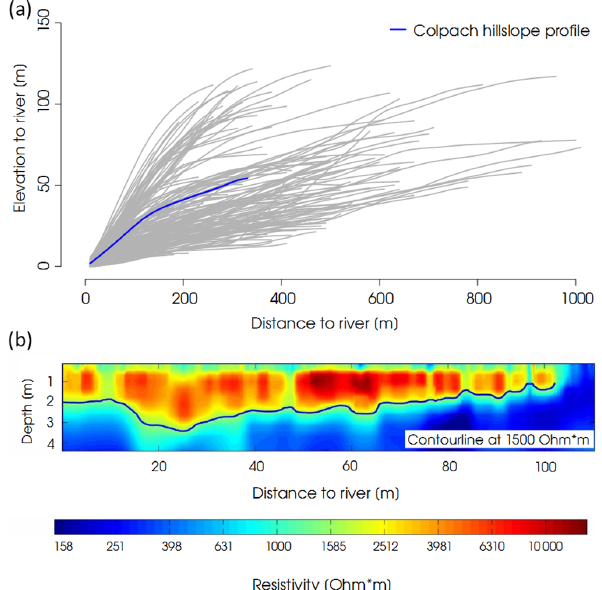
Figure 6. (a) Profile of all hillslopes extracted from a DEM in the Colpach catchment. Hillslope profile we used in this study high- lighted in blue. (b) Bedrock topography of a hillslope in the schist area measured using ERT. The contour line displays the 1500 (cid:127) m isoline which is interpreted as the soil–bedrock